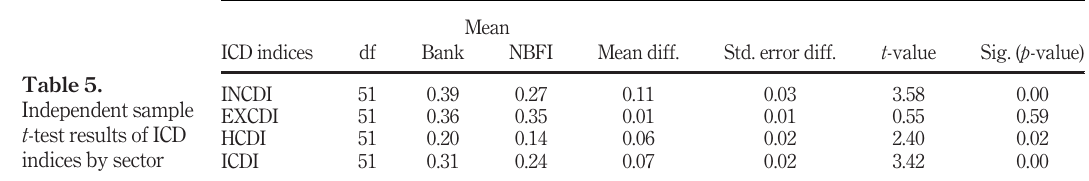
Table 5. Independent sample t -test results of ICD indices by